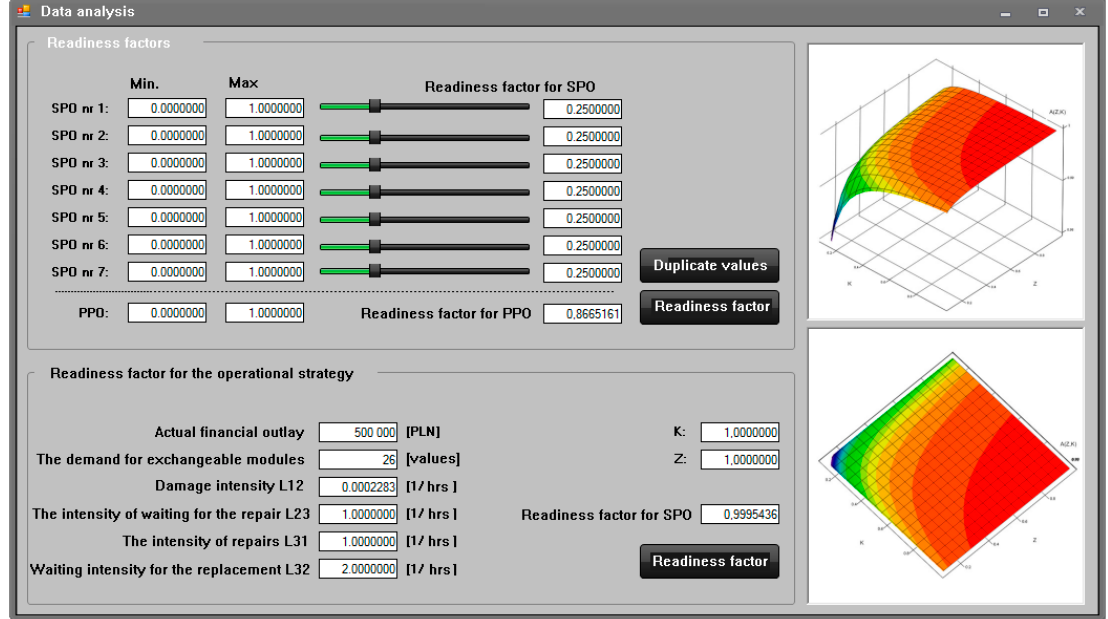
Figure 7. View of the system software while working in the second mode of determining the reliability indicators for the toll collection station and grouping the stations in the MTC collection. Source: own